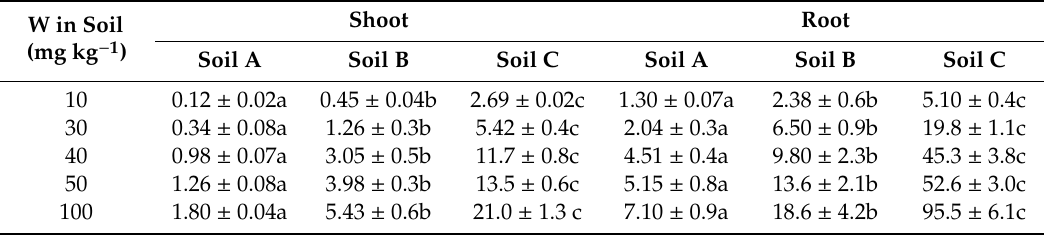
Table 3. Tungsten concentration in shoots and roots of Zea mays grown in the di ff erent spiked soils. Values are the mean ± standard deviation.